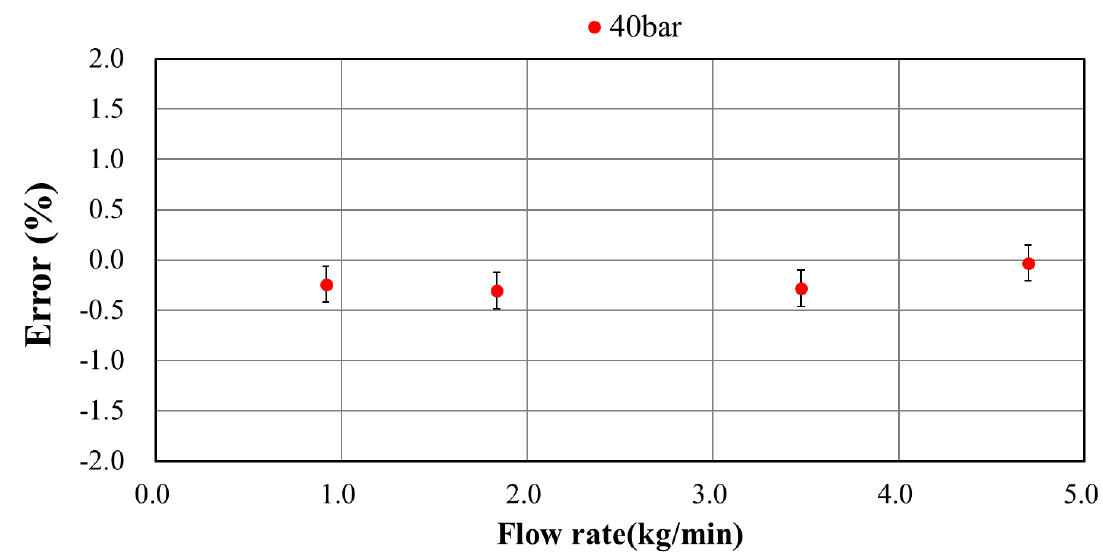
Figure 7. Measurement results of Coriolis mass flowmeters with the density-matching approach.